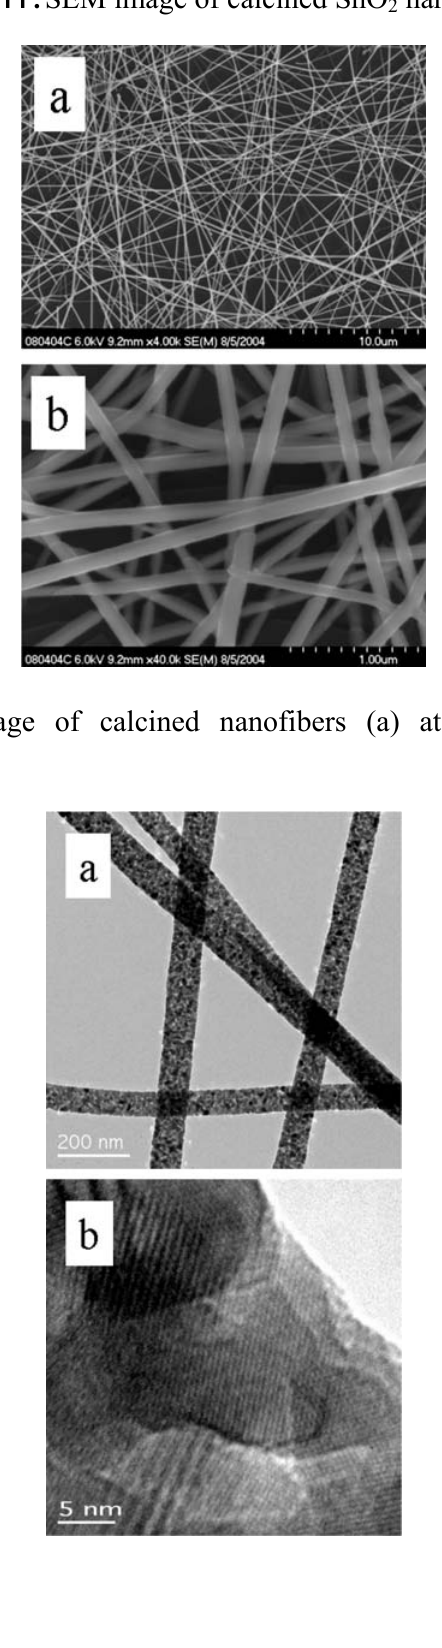
Figure 11. SEM image of calcined SnO